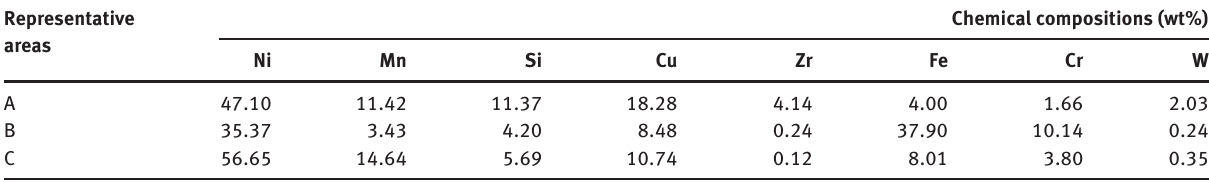
Table 4: Chemical compositions of representative areas of NiMnSiCuZr brazing seam region. Representative